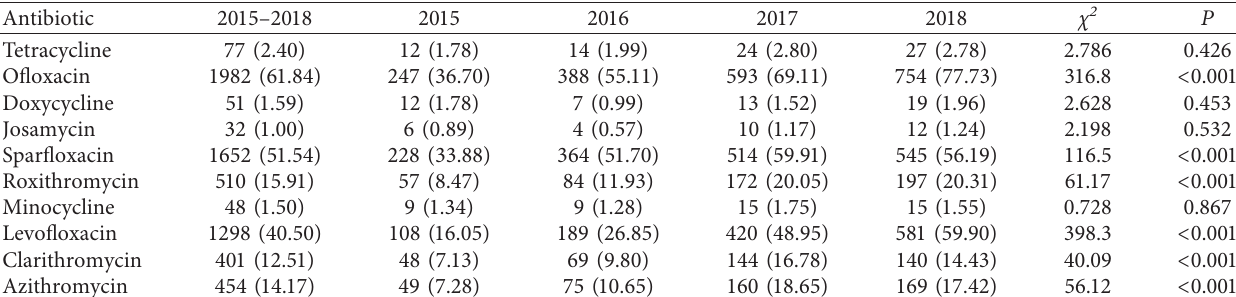
Table 4: Antibiotic resistance of U. urealyticum and M. hominis from 2015 to